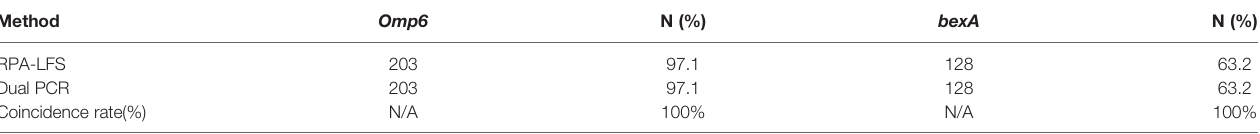
TABLE 3 | 209 strains using RPA-LFS and dual